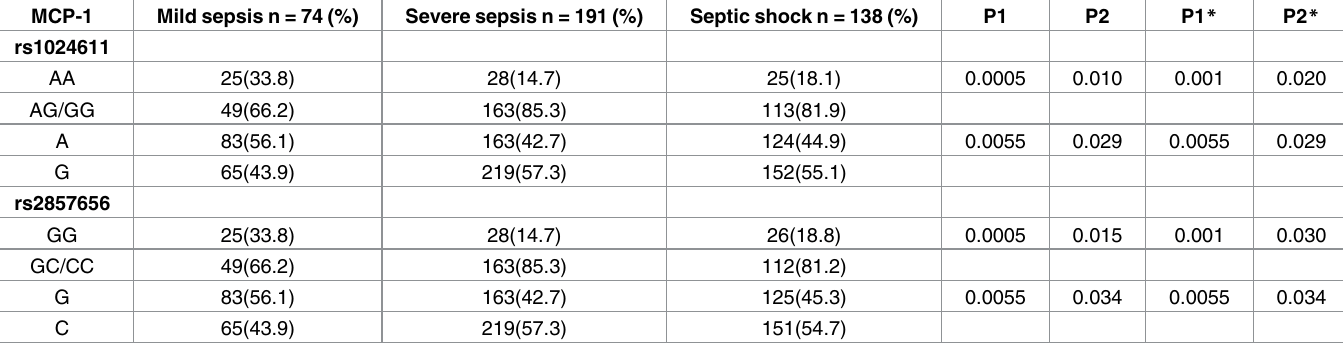
Table 3. Genotype and allele frequencies distribution in the different sepsis status.